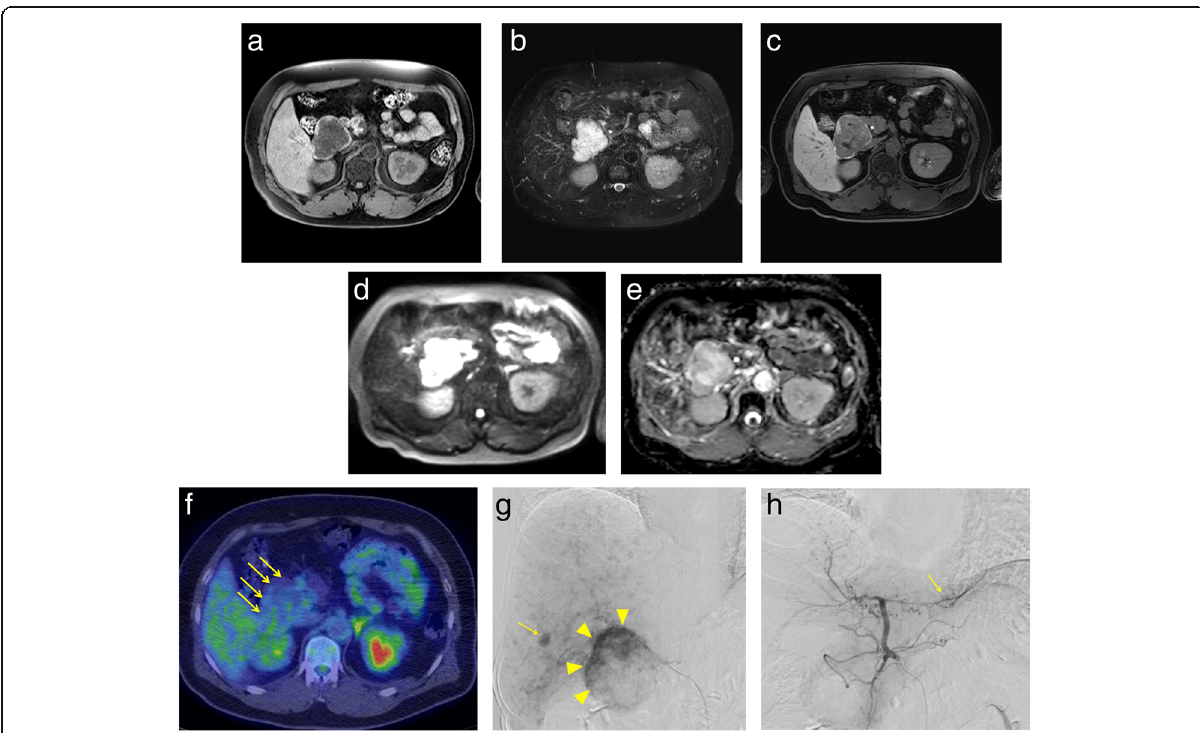
Fig. 2 Magnetic response imaging (MRI), [ 18 F]-fluorodeoxyglucose positron emission tomography (FDG-PET) and hepatic arteriography. MR images showing low-signal intensity on T1-weighted images ( a ) and high-signal intensity on T2-weighted images ( b ). EOB-MRI revealed a hypointense mass in the hepatobiliary phase ( c ). The ADC mean of DW-MRI in the mass was 2.33×10 − 3 mm 2 /s ( d , e ). There is no accumulation of [ 18 F]-FDG ( f ). Hepatic arteriography showing hypervascular masses in S1, S6 ( g ), and S2 ( h ) of the liver; there is no